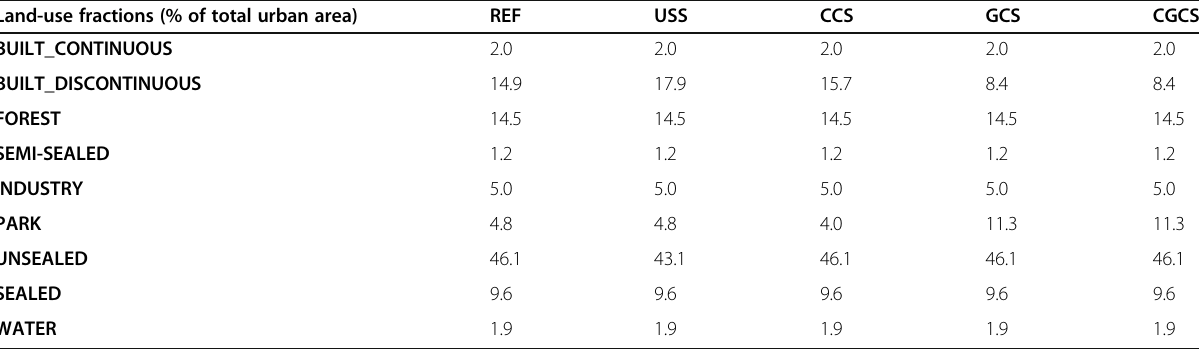
Table 3 Percentage fraction of land-use in Braunschweig (reference case) and for step 10 of the respective development scenario (USS: Urban Sprawl Scenario, CCS: Compact City Scenario, GCS: Green City Scenario, CGCS: Compact Green City Scenario) Land-use fractions (% of total urban area)